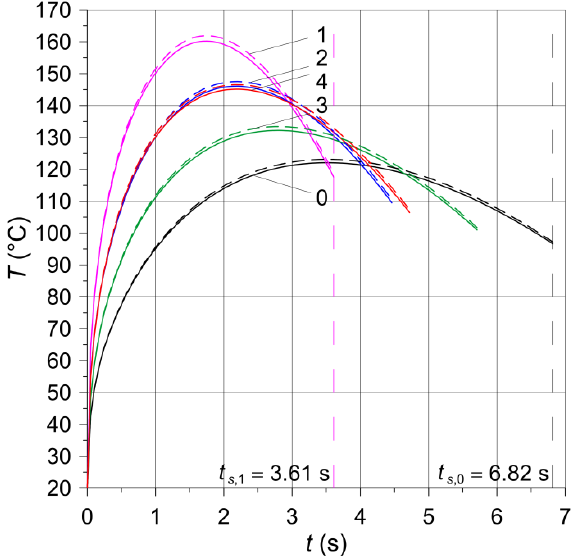
Figure 5. Evolution of the temperature of the friction surfaces of the clutch on the equivalent radius r eq = 39.4 mm with constant (solid lines) and temperature-dependent (dashed lines) properties of 65H steel for five friction materials. Numbers 0–4 denote friction materials given in Table 1. Table 3. Calculated parameters of the braking process for five friction materials. Variant,